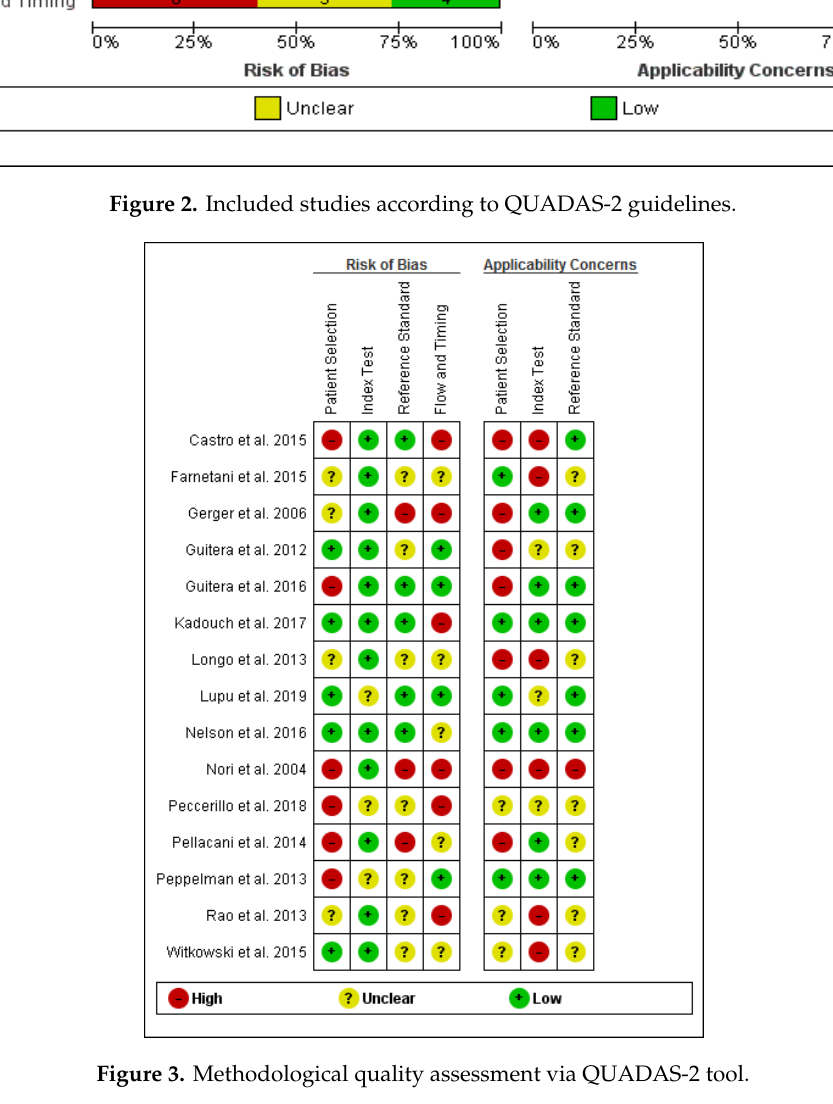
Figure 3. Methodological quality assessment via QUADAS-2 tool.